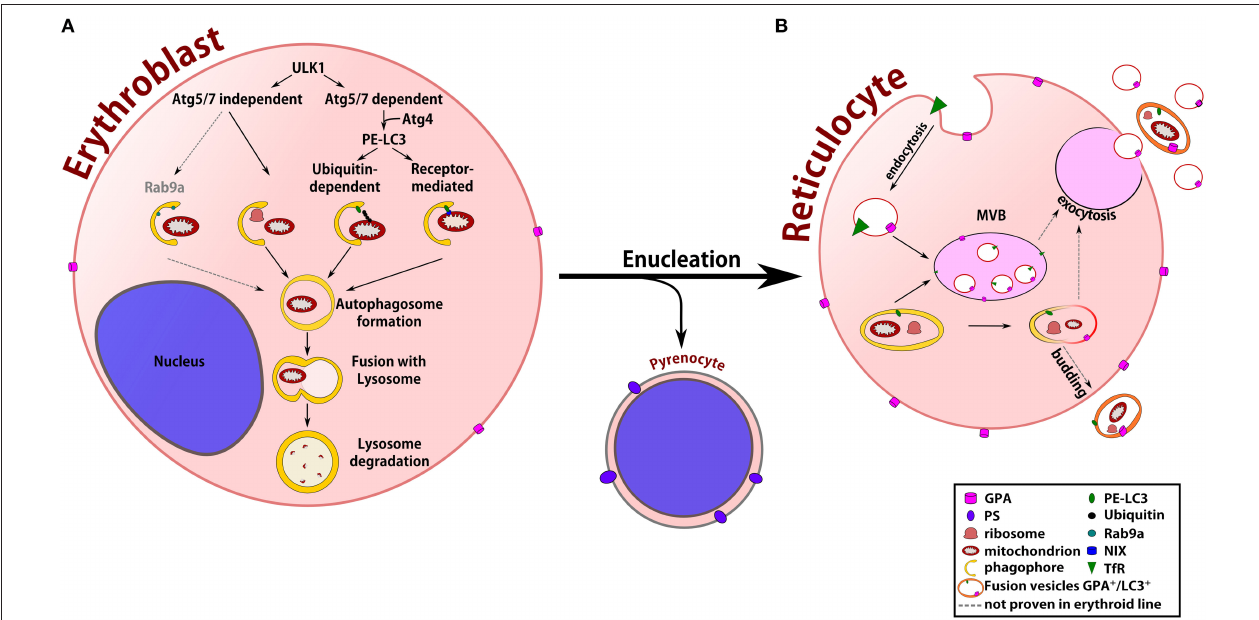
FIGURE 1 | Terminal maturation of erythroblasts. (A) At the erythroblast stage, two Ulk1-mediated autophagic pathways are activated to allow organelle clearance: the Atg5/7-dependent pathway with the proteolytic Atg4-dependent activation of MAPLC3, microtubule-associated protein 1 light channel 3 (LC3) and the Atg5/7-independent pathway, which is not related to the LC3 protein. LC3 activation allows its insertion into the phagophore membrane, starting the engulfment of organelles through the recognition of an ubiquitin signal or by the direct binding of specialized receptors at the organelle membrane. In non-erythroid cells, Rab9a is important for the formation of the phagophore during the Atg5/7-independent autophagic pathway. After the formation of the autophagosome, its fusion with the lysosome permits the degradation of organelles by hydrolytic enzymes. The enucleation process gives rise to the pyrenocyte and the reticulocyte, which still contains some organelles that must be eliminated for the final maturation into erythrocyte. (B) During this stage, unwanted membrane proteins, such as transferrin receptor (TfR), are internalized by endocytosis and expelled by exocytosis from multi-vesicular body structures. Glycophorin A (GPA)/LC3 double-positive vesicles containing organelle remnants are also found in reticulocytes, suggesting cooperation between the endocytosis (GPA + ) and autophagy (LC3 + ) pathways to eliminate organelles. How autophagosomes interact with multivesicular bodies (MVBs) following the same pathway of membrane protein recycling or budding directly from the plasma membrane after fusion with endocytic vesicles, however, remains